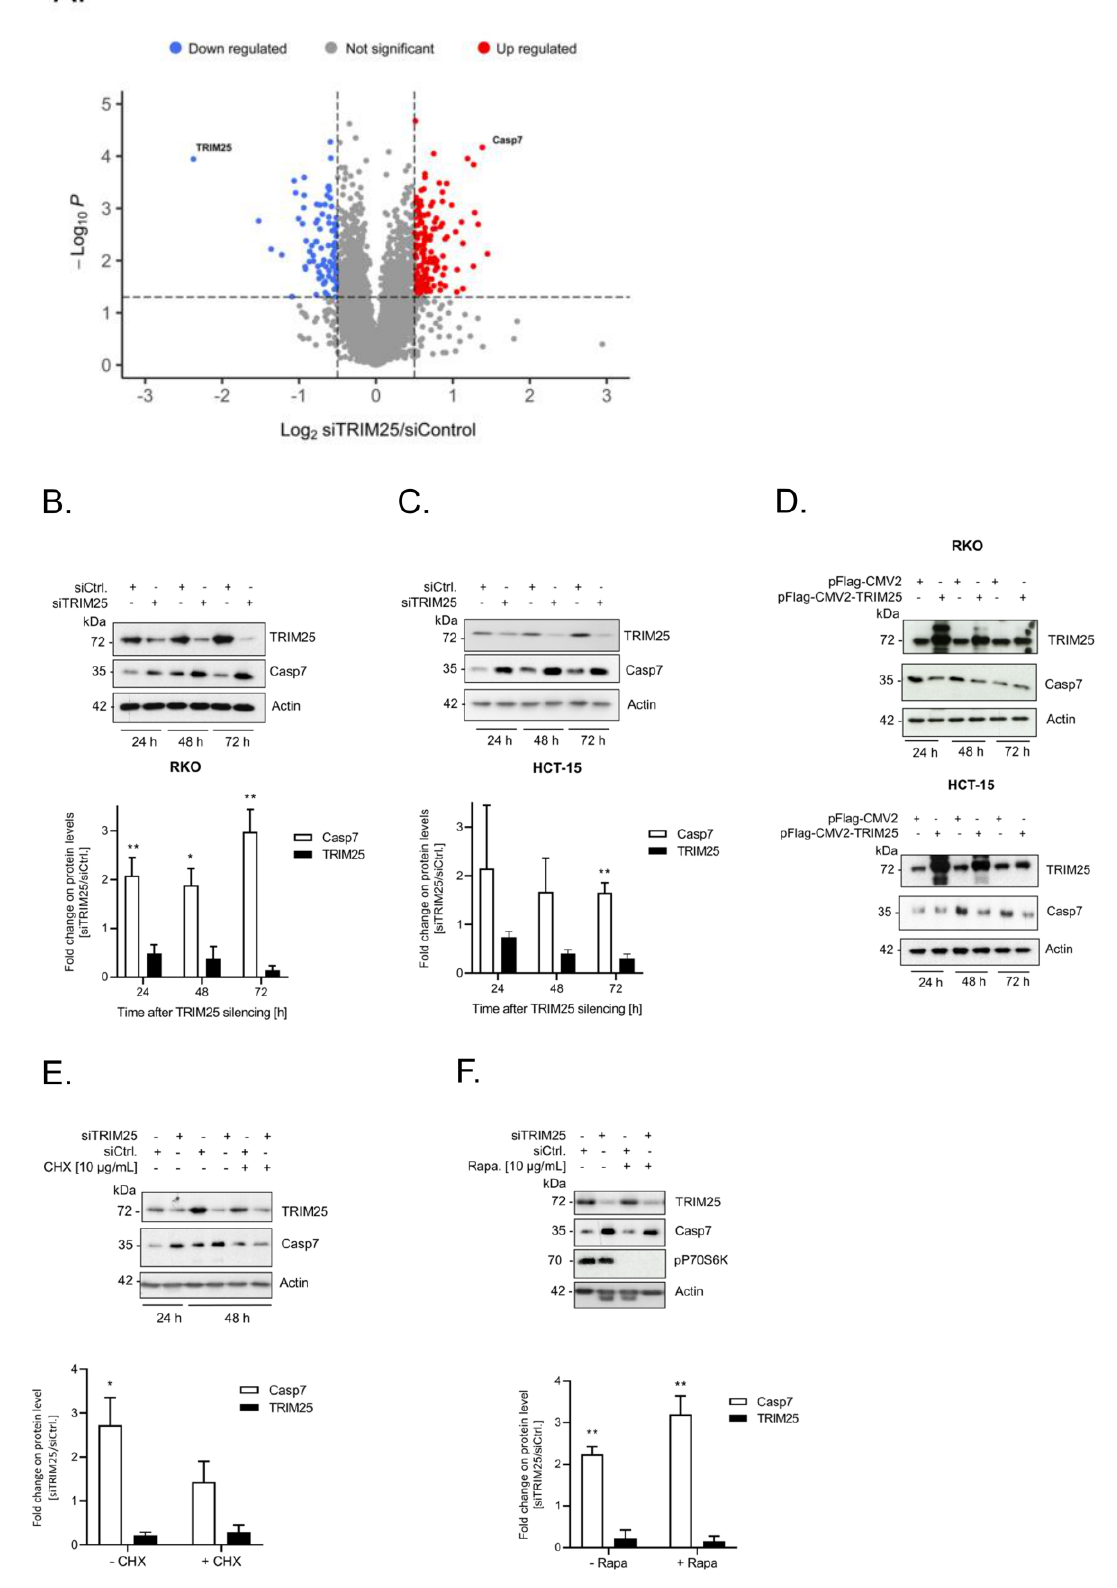
Figure 1. ( A – D ). Silencing of TRIM25 is concomitant with elevated caspase-7 protein level. ( A ) Volcano plot diagram showing LC/MS data from the analysis of RKO cells transfected for 48 h with control siRNA duplexes (siCtrl.) versus cells transfected with siRNA duplexes of TRIM25 (n = 4). Colored dots depict significantly ( p ≤ 0.01) upregulated (red) and downregulated (blue) proteins (fold changes ≥ or ≤ 0.5 -fold). For clarity, only the positions of TRIM25 and caspase-7 are shown.